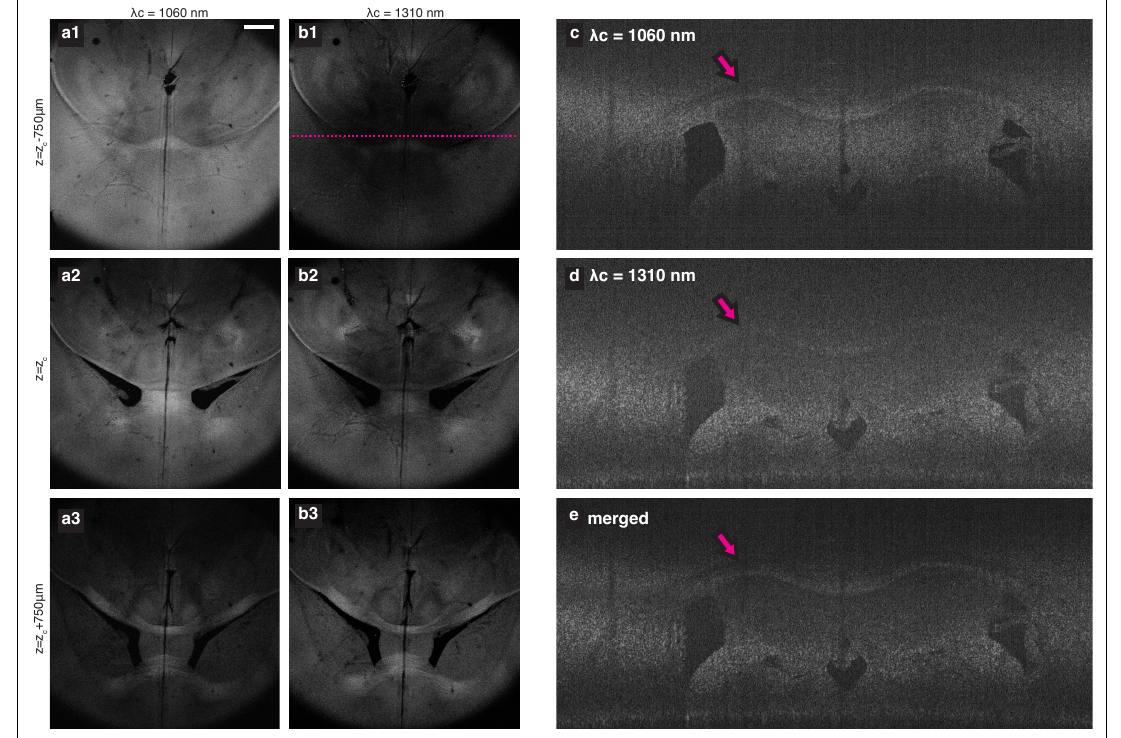
Figure 4. Dual-band imaging results of cleared murine brain. ( a , b ) Sectional MIP of two horizontal planes that are 0.75 mm apart. Comparison of a coronal section taken from ( c ) the 1060 nm band, ( d ) the 1310 nm band, and ( e ) the merged stack. Tomograms in ( c – e ) are taken at the line marked in ( b1 ). The magenta arrows mark the corpus callosum, which is better captured by the 1060 nm system and therefore displayed with increased contrast in the merged